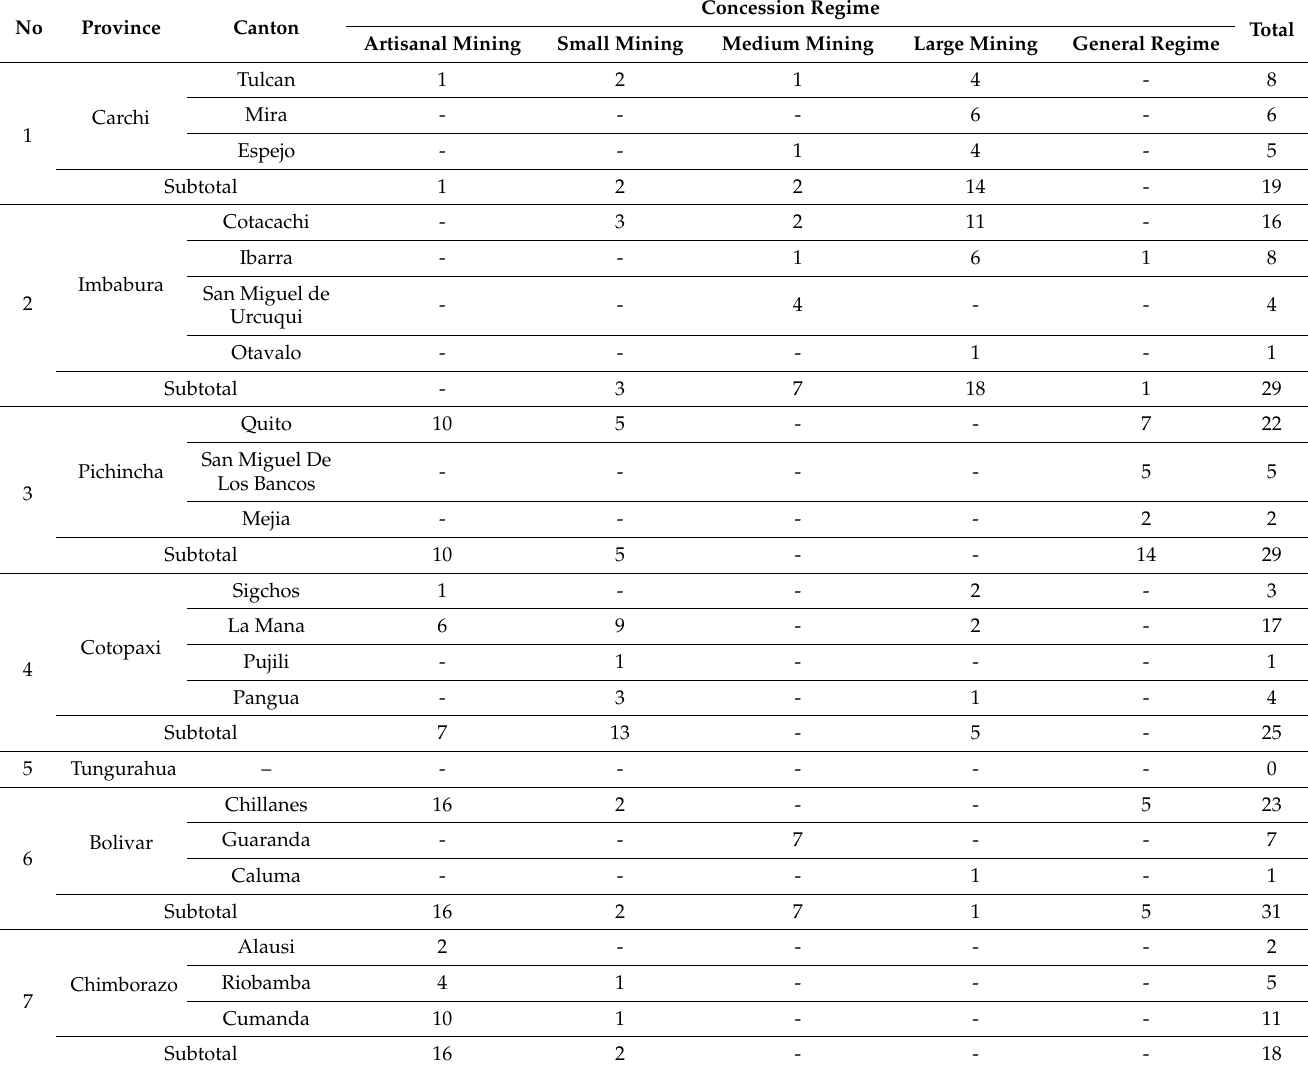
Table 1. Registered Au mining concessions in the Andean zone of